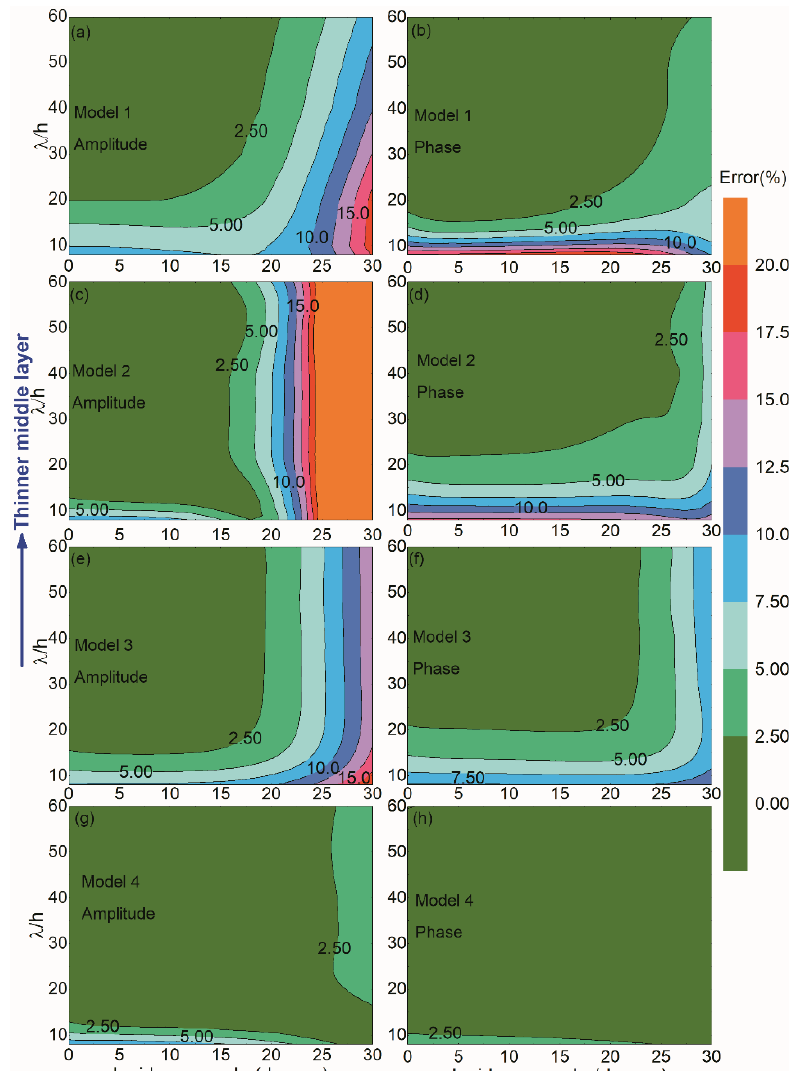
Figure 4. Absolute values of relative errors of thin-bed P-wave reflection coefficients caused by the linear analytic approximation: ( a ) amplitude of Model 1; ( b ) phase of Model 1; ( c ) amplitude of Model 2; ( d ) phase of Model 2; ( e ) amplitude of Model 3; ( f ) phase of Model 3; ( g ) amplitude of Model 4; ( h ) phase of Model 4.